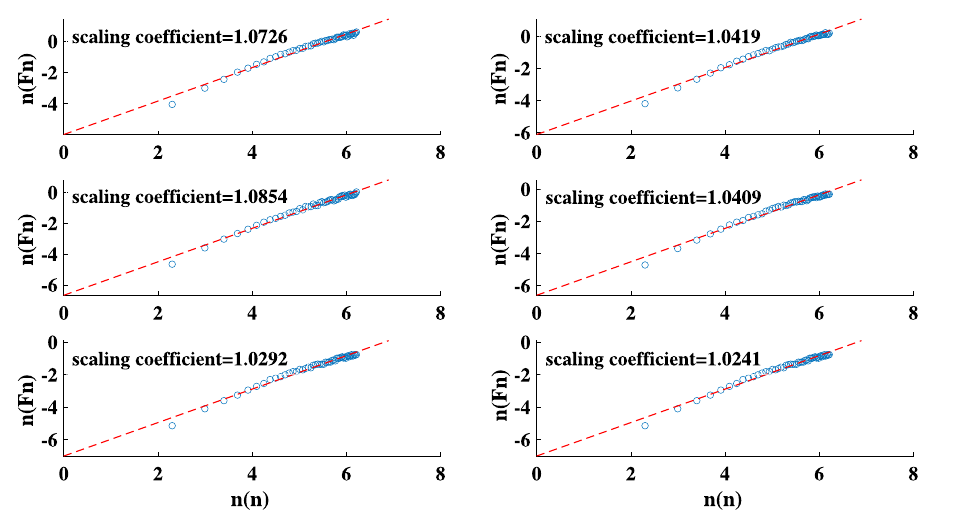
Figure 7. The scaling coefficient of the DFA for the simulated light curves of the nano-flare emission model with α =1.4, 1.6, 1.8, 2, 2.2,